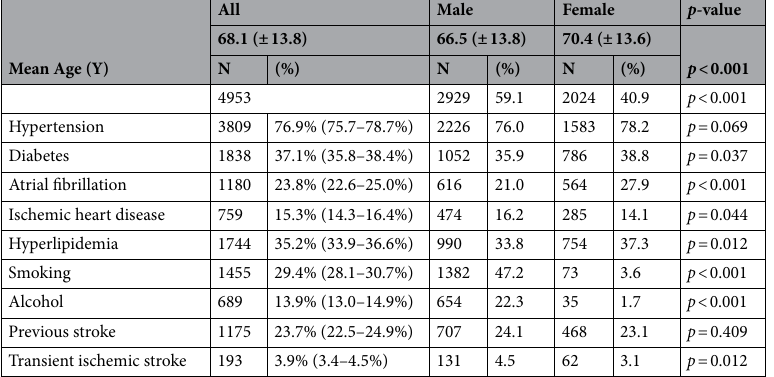
Table 1. Study characteristics and risk factor distributions in ischemic stroke patients in NTUH Stroke Registry. NTUH National Taiwan University Hospital, Y year, N number.